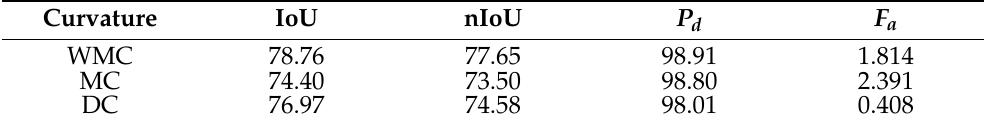
Table 5. Different curvature experiment for the IoU (%), nIoU (%), P d (%), and F a (10 − 5 ). Curvature